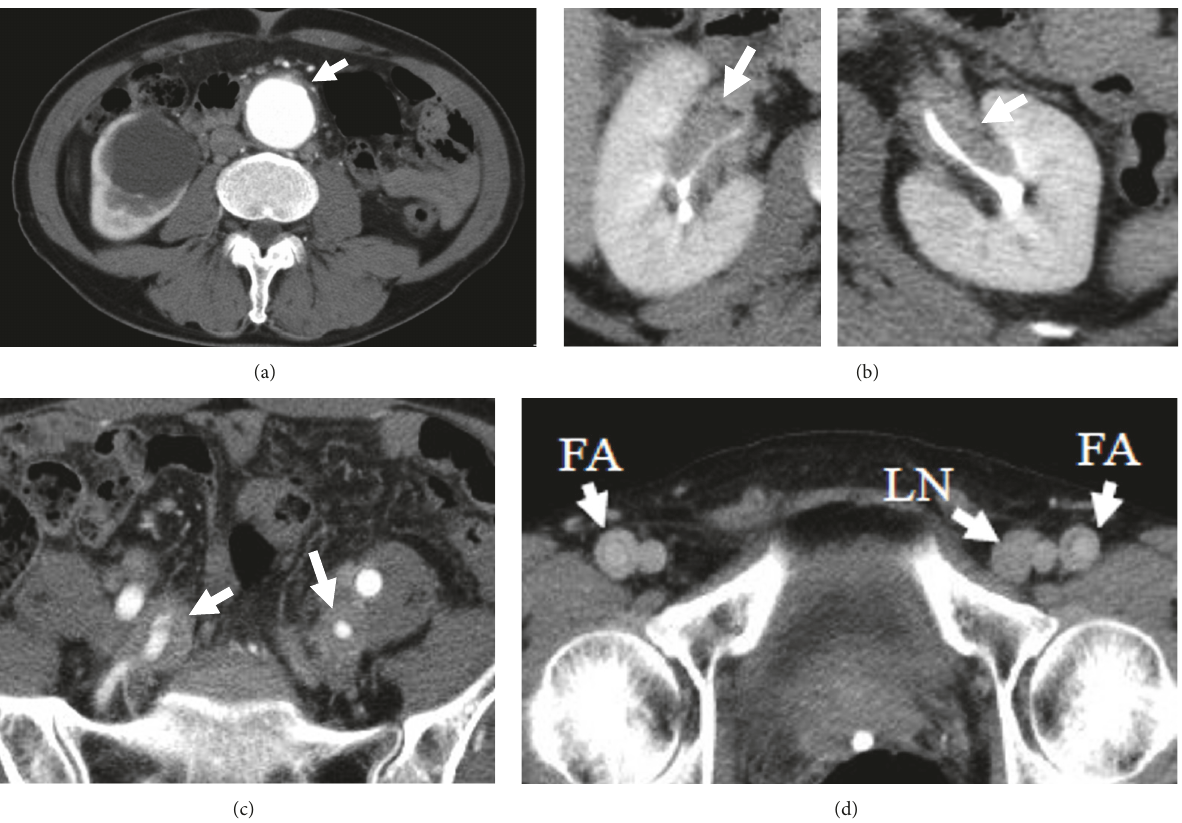
Figure 3: CT scan when the patient first came to our hospital. (a) The abdominal aorta was enlarged, and the adventitia was thickened. (b) Soft tissues around the ureters were thickened. (c) The tissue around the bilateral internal iliac arteries was thickened. (d) The adventitia of the bilateral femoral arteries was thickened and lymph nodes were swollen. CT, computed tomography; FA, femoral artery; LN, lymph node.